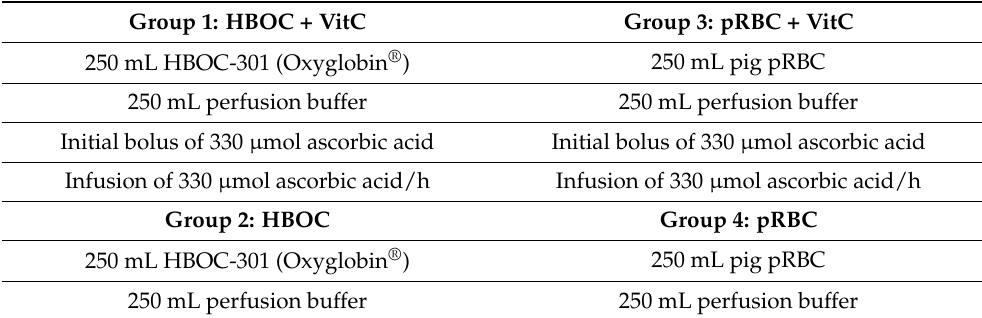
Table 1. Perfusate composition of the four perfusion groups. Group 1: HBOC + VitC Group 3: pRBC + VitC 250 mL HBOC-301 (Oxyglobin ® ) 250 mL pig pRBC